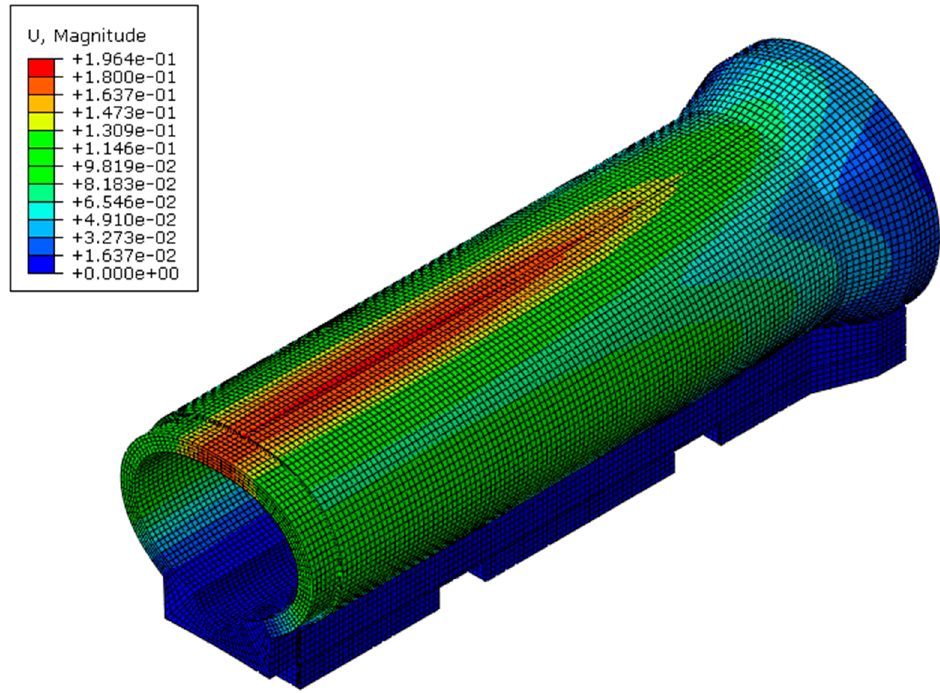
Figure 15. Displacement distribution by line load (Model 2 case).